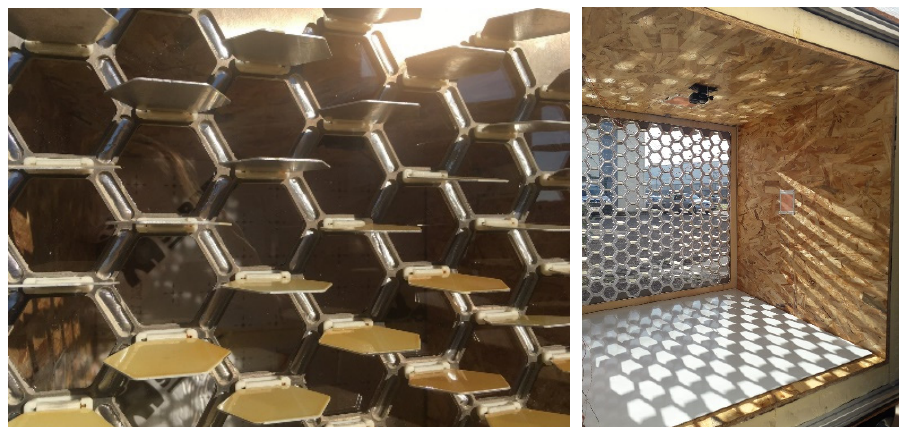
Figure 11. Photos of the Stegos ‘glazing’ configuration on the test box with claps positioned as solar caps and opened to a 90° angle. Camera fixed on the roof wall of the test box.